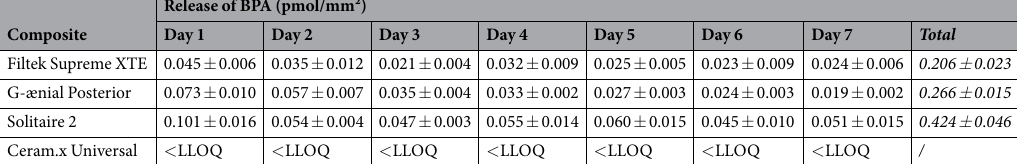
Table 2. Released BPA quantities eluted from resin-based dental materials over a period of 7 days. Values are mean ± SD, n = 5. ( < LLOQ: below lower limit of quantification (i.e. 0.03 pmol BPA/mm²); /: no accurate quantification